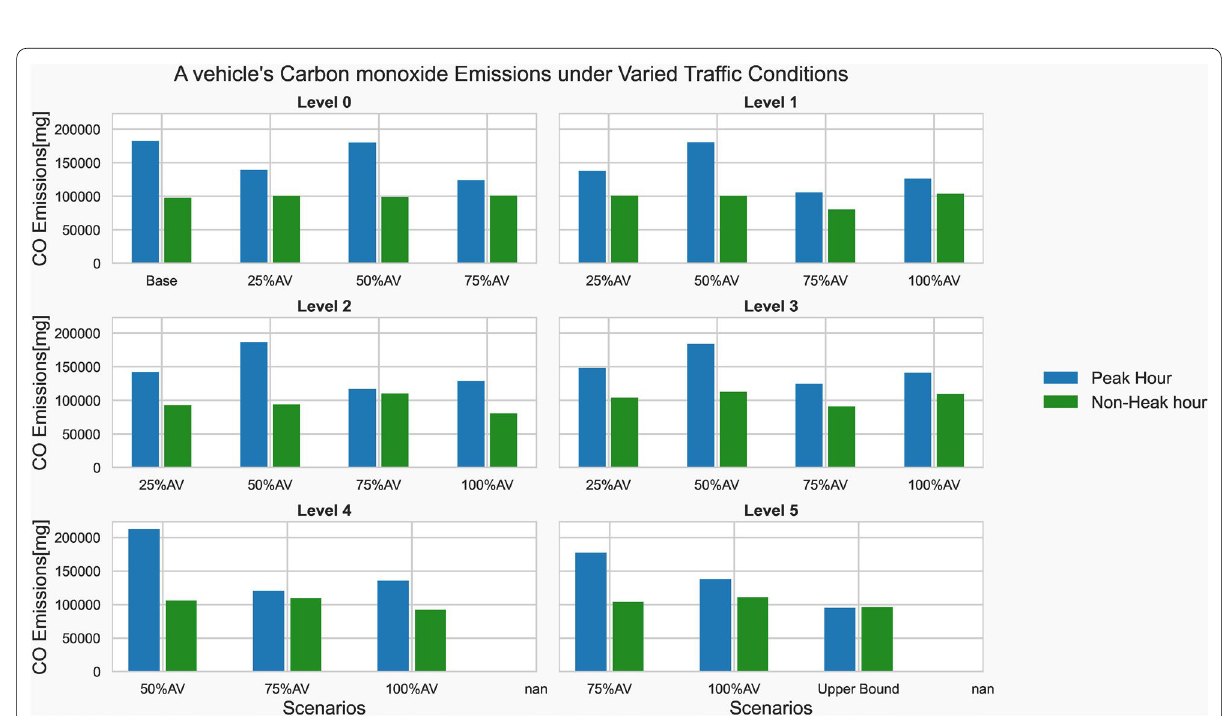
Fig. 8 Individual vehicle emission